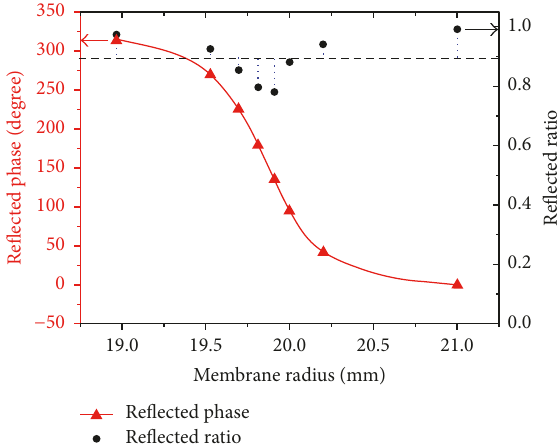
Figure 2: Reflected phases and ratios of the eight subunits as a function of 𝑟 . The wavelength 𝜆 of the incident wave is 600 mm. The red triangles and black dots refer to discrete phases and ratios of eight subunits having specific membrane radius (i.e., 18.97, 19.53, 19.70, 19.81, 19.91, 20.00, 20.20, and 21.00 mm, respectively). The phase shift between two adjacent subunits is 45 ∘ . The mean reflected ratio is 0.89, as shown by the dashed